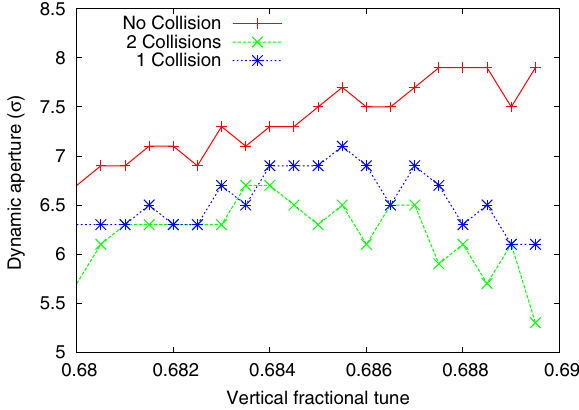
FIG. 11. Calculated off-momentum dynamic apertures for the Blue ring in a tune scan along the diagonal in the tune space between 2 = 3 and 7 = 10 . The particle energy is 255